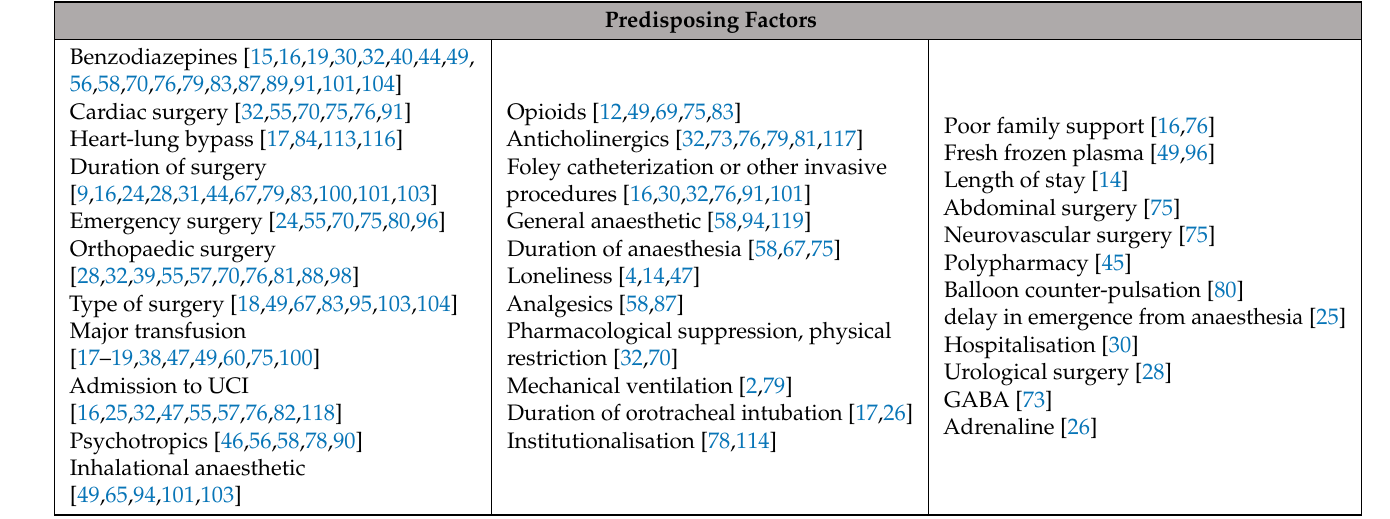
Table 2. Precipitating